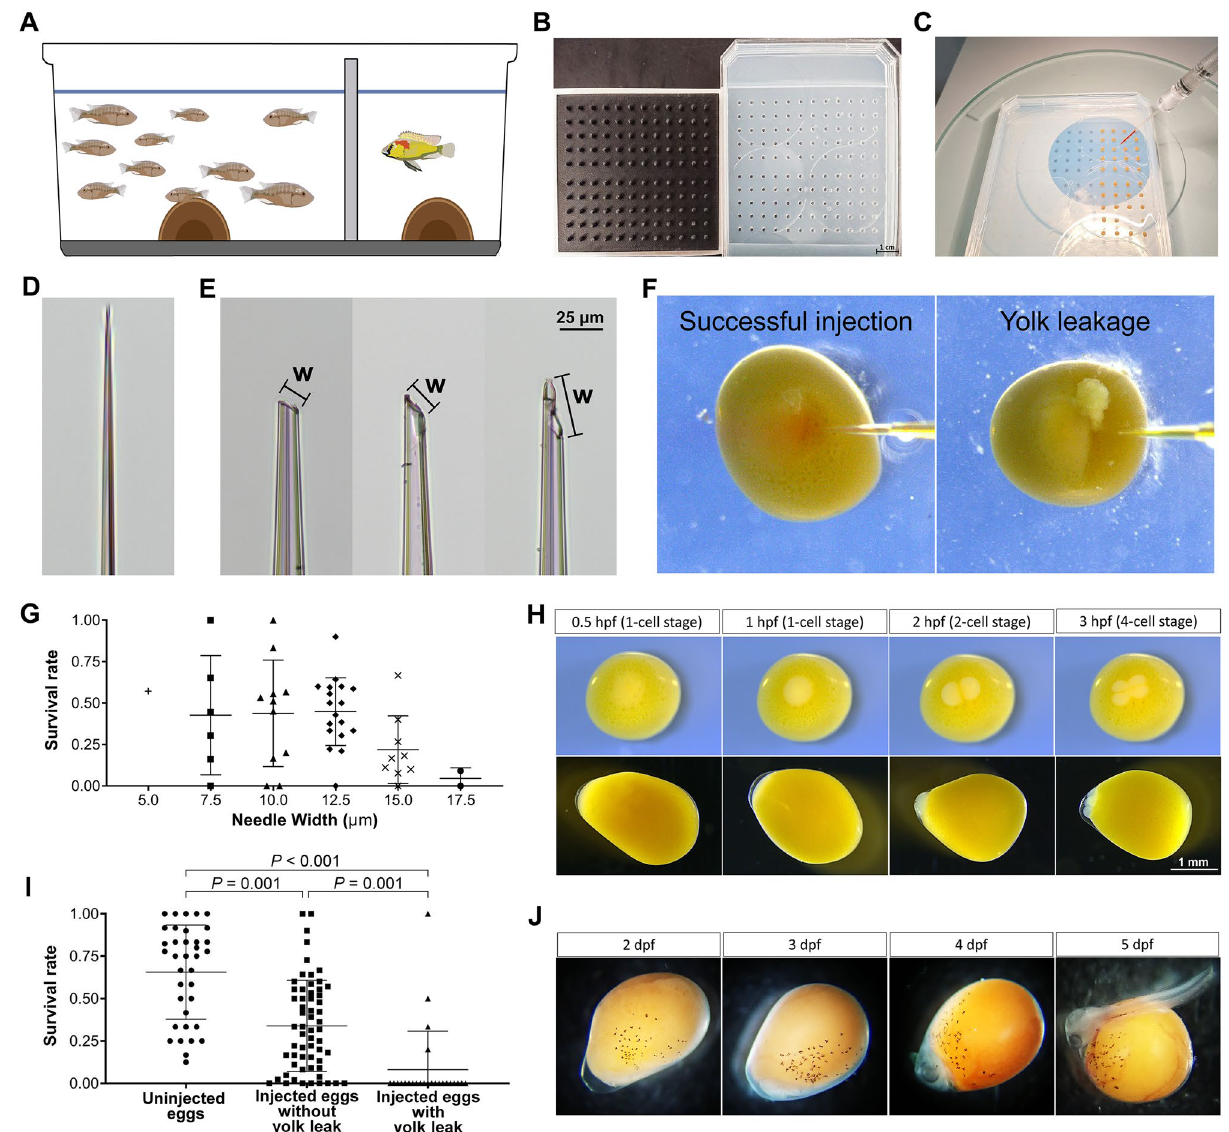
Figure 3. Cichlid embryo collection and injection. ( A ) 20–30 L breeding tanks contain ~ 10 adult females separated by a transparent barrier from a stud male. ( B ) A 3D-printed mold (left) for making gel embryo-holder (right). ( C ) Single-cell embryos loaded for injection with CRISPR components. ( D , E ) Example of injection needles before ( D ) and after ( E ) tip opening. Note that the variation in the shape of microinjection needles could impact both the volume of reagents injected and the extent of damage to the embryo. ‘W’ represents ‘needle width’, which is defined as the long axis of the needle’s angled opening. ( F ) An example of successful injection (left) versus yolk leakage (right). The survival rate of embryos at 5–7 dpf, dependent on ( G ) the outer diameter of the needle used and ( I ) the presence of yolk leakage. Each data point consists of a single brood injected by a unique needle, and bars represent mean ± SD. Mann–Whitney U test was used to test for differences between groups. ( H ) Dorsal (top panel) and lateral view (bottom panel) of embryo development progress from single-cell stage (0.5 hpf [hours post-fertilization], two-cell stage (2 hpf), to four-cell stage (3 hpf). ( J ) Embryo development from 2 dpf (days post-fertilization) to 5 dpf. Note that eumelanin pigmentation on yolk appears at 2 dpf; pigmented optic cups with lens placodes become discernible at 4 dpf; tail region separates from yolk (hatching) by 5